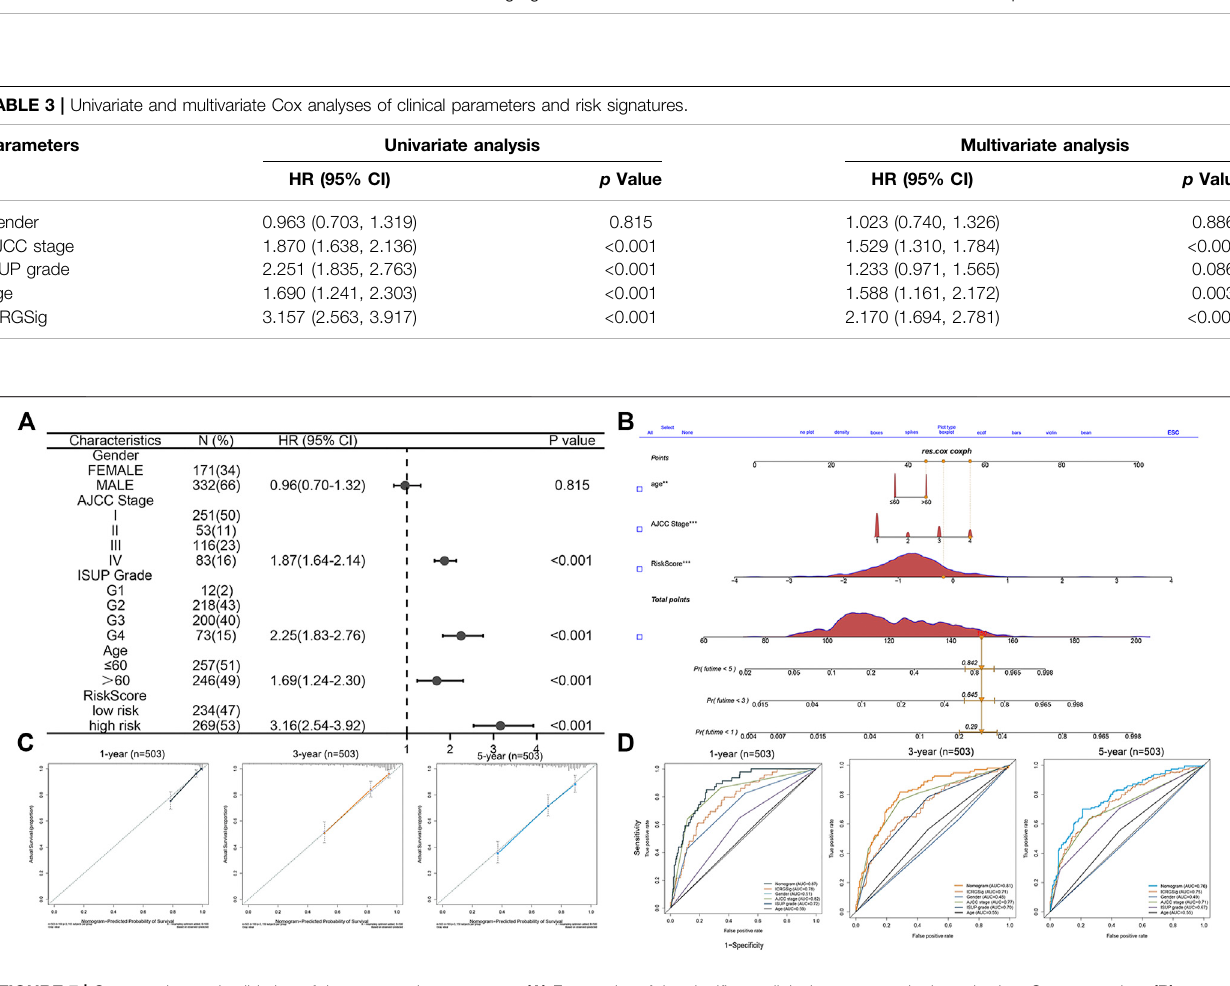
FIGURE 7 | Construction and validation of the prognostic nomogram. (A) Forest plot of the signi fi cant clinical parameters in the univariate Cox regression. (B) Nomogram based on the signi fi cant clinical parameters and risk signatures. (C) Calibration curves of the nomogram for 1-, 3-, and 5-year survival prediction. (D) Predictive value of the nomogram, risk signature, and clinical